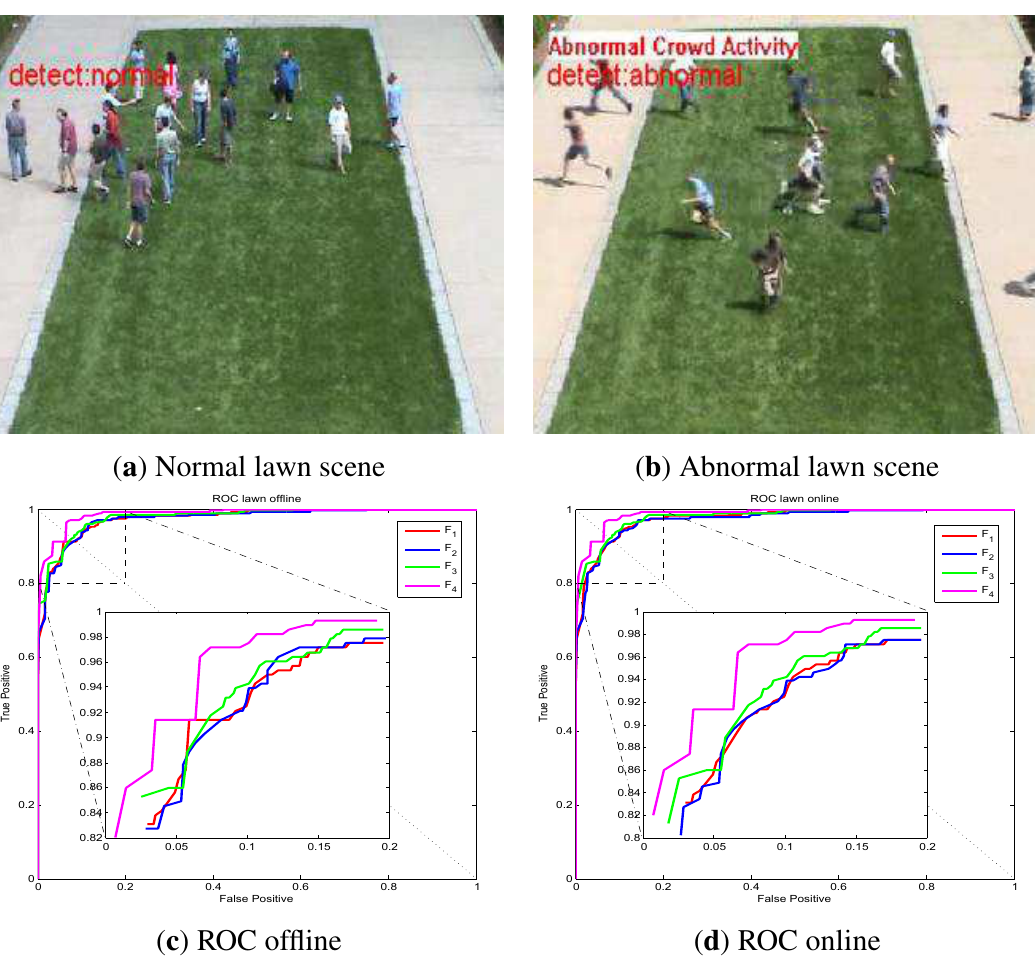
Figure 7. Detection results of the lawn scene. ( a ) The detection result of a normal frame; ( b ) The detection result of an abnormal panic frame; ( c ) Receiver operating characteristic (ROC) curve of covariance descriptors constructed from different features F of the lawn scene detection results via LS-OC-SVM. All the training samples are learned together offline. The biggest AUC value is 0.9874; ( d ) ROC curve of detection results via online LS-OC-SVM. The biggest AUC value is